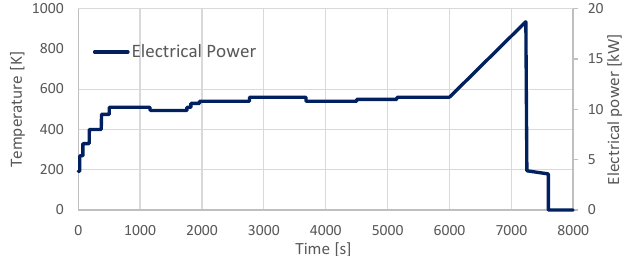
Fig. 5. Power history used in the